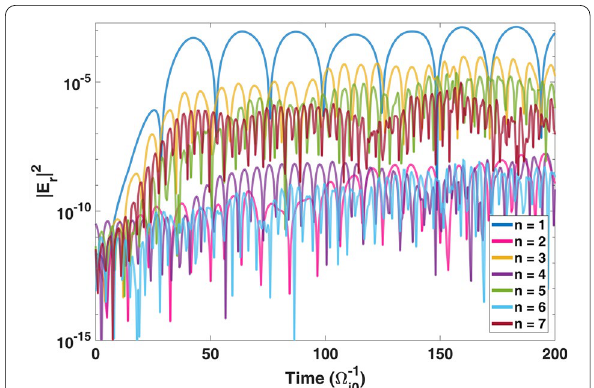
Fig. 8 Case I: wave power spectra of E r over time for the first 7 8 R E . The wave power harmonics at the subsolar equator and L = appears not to grow or decay. It also clearly shows the wave power trend at the equator for E r , i.e., the odd harmonics are much stronger than the negligible even harmonics, and the higher the harmonic order, the weaker the corresponding wave